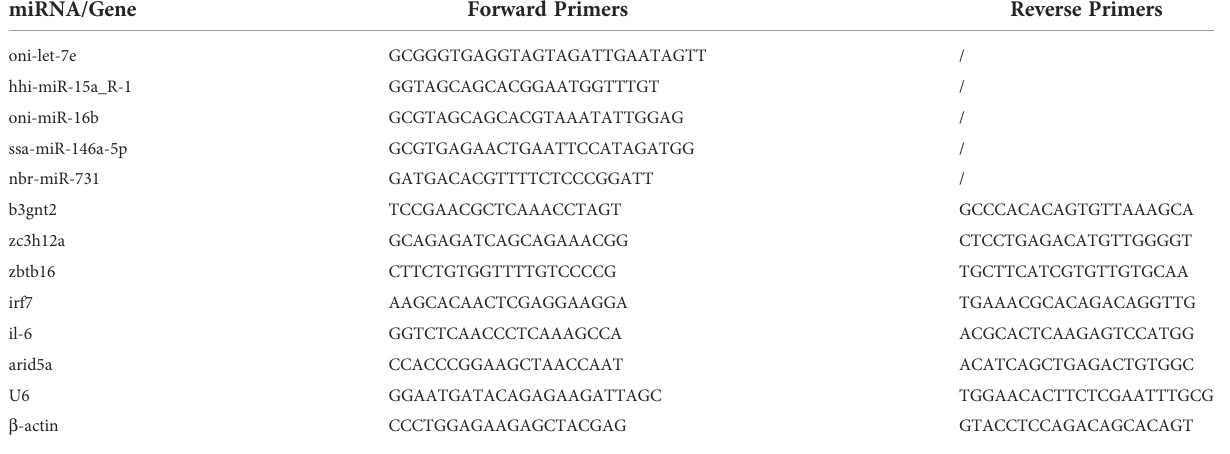
TABLE 1 Sequences of the primers used for gene and microRNA (miRNA) expression analysis by quantitative real-time PCR. miRNA/Gene Forward